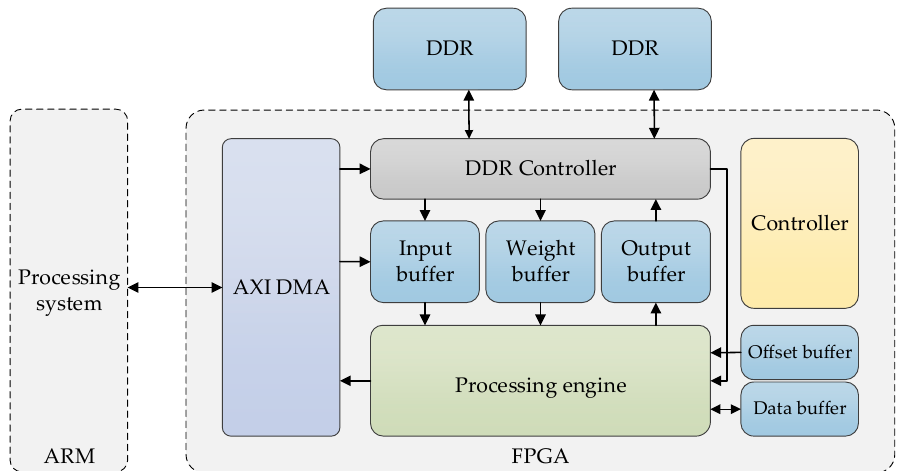
Figure 4. The overall architecture of the proposed hardware accelerator.